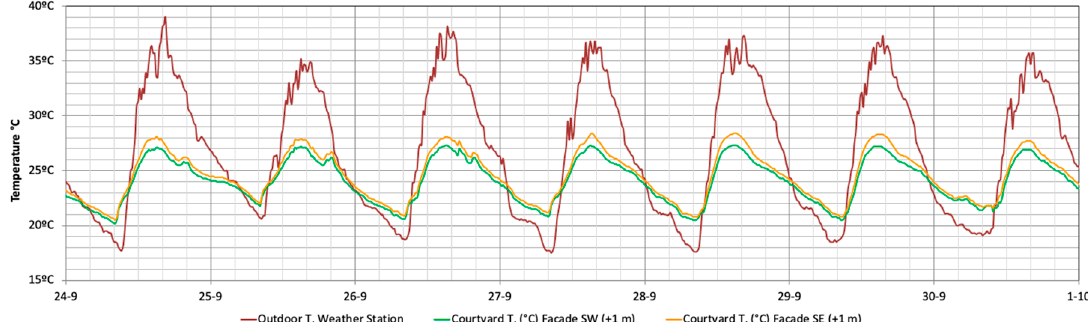
Figure 15. Case study 2: thermal behavior (24 Sept/01 October) after vegetal facade installation.